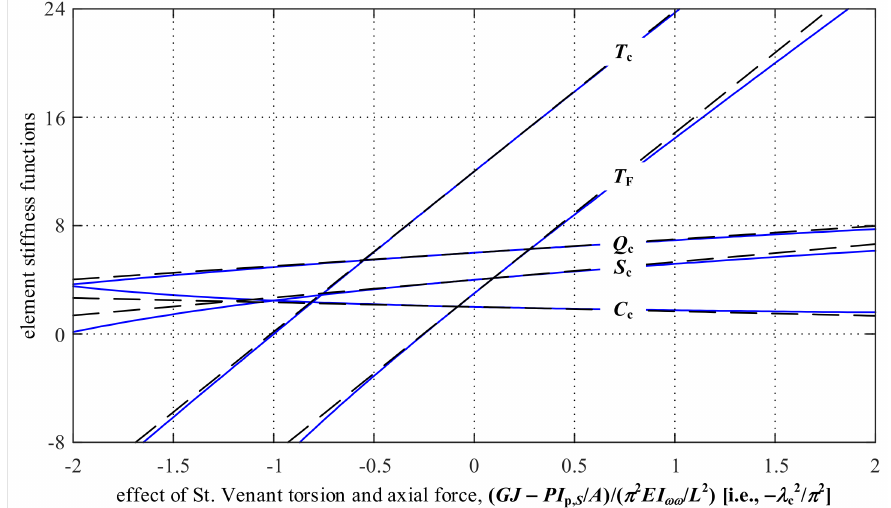
Figure 4. Influence of GJ - PI p,S / A on element stiffness functions T c , Q c , S c , C c , and T F